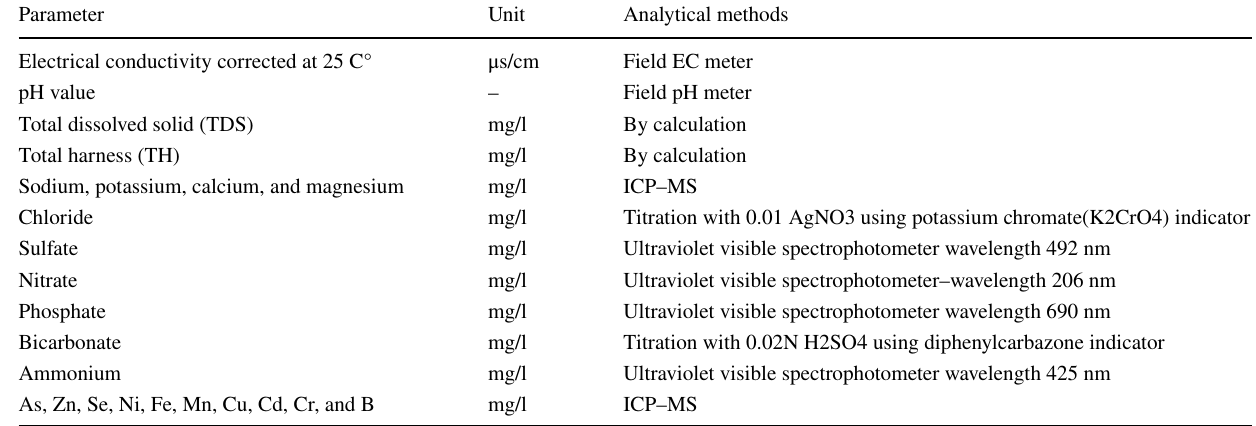
Table 2 Methods of analysis used to determine physical and chemical analyses of groundwater samples